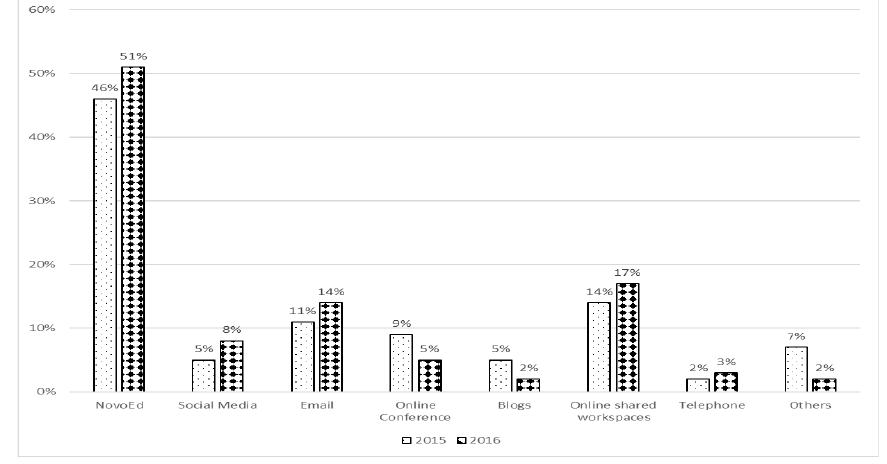
Fig. 6. Which tools were used?